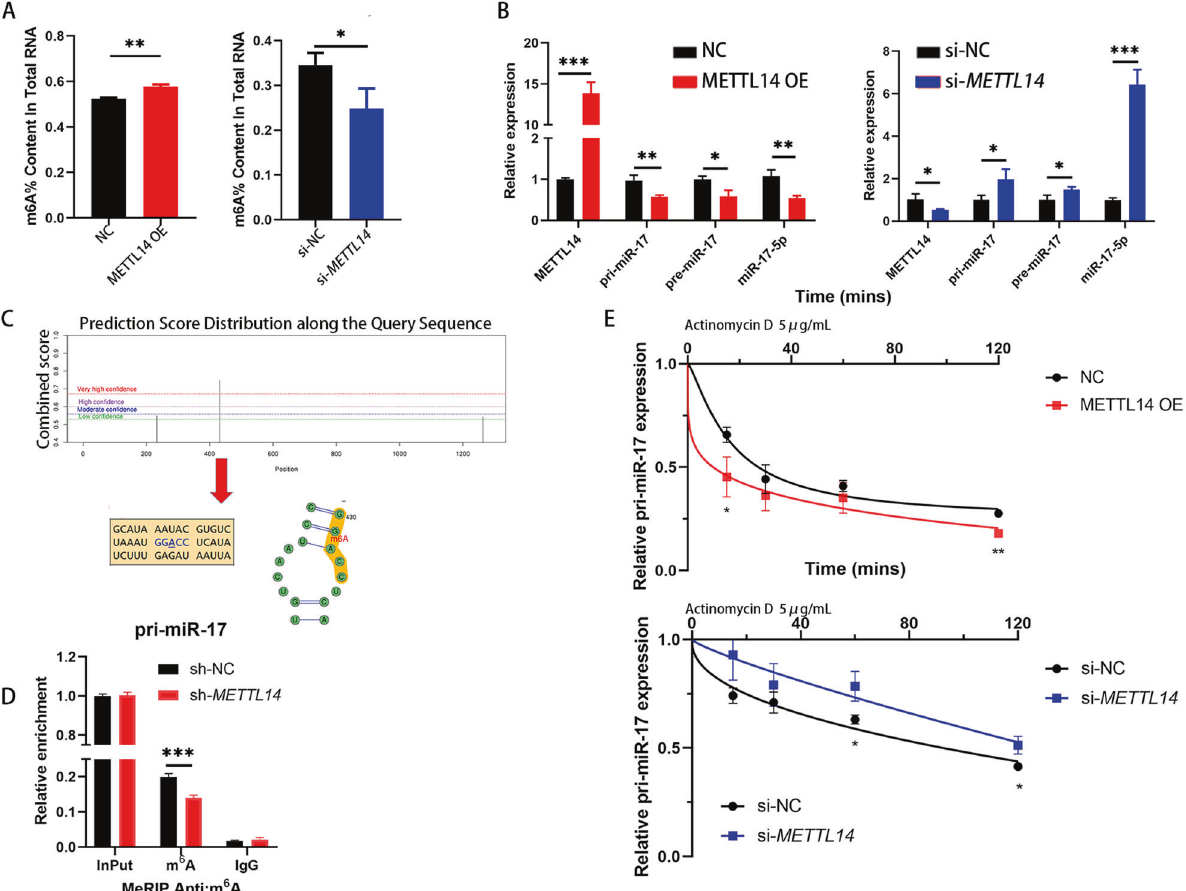
Fig. 4 METTL14 regulates miR-17-5p expression through m 6 A modi fi cation. A Colorimetric quanti fi cation of m 6 A levels in HCT116 cells after METTL14 knockdown ( P = 0.0322) or overexpression ( P = 0.0012). B Relative expression of pri-miR-17, pre-miR-17 and miR-17-5p after METTL14 knockdown ( P = 0.0335, 0.0313, 0.0322, 0.0002 respectively) or overexpression (P = 0.0001, 0.0084, 0.0121, 0.0049 respectively). C Possible m 6 A modi fi cation sites on the pri-miR-17 predicted by SRAMP database. D MeRIP and MeRIP-qPCR analysis demonstrating pri-miR- 17 m 6 A modi fi cation in sh-NC and sh- METTL14 cells, P = 0.0009. E qPCR analysis of pri-miR-17 levels in different HCT116 cells groups after actinomycin D treatment. P (NC vs. METTL14 OE, 15 mins = 0.0272, 120 mins = 0.0021); P (si-NC vs. si- METTL14 , 60 mins = 0.0209, 120 mins = 0.0175). Results shown were representative of at least 3 independent experiments. Statistical signi fi cance in ( A ), ( B ), ( D ), ( E ) was assessed by student ’ s t-test. *, P < 0.05; **, P < 0.01; ***, P < 0.001. Error bars,